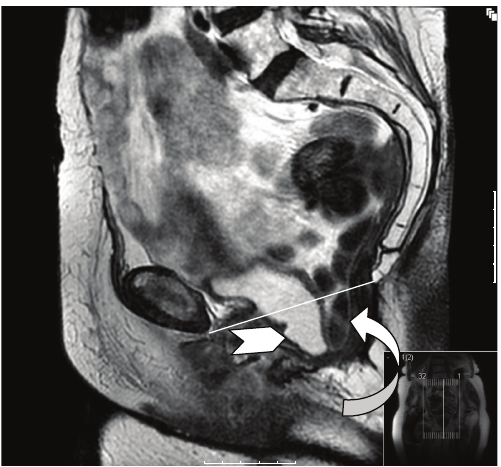
Figure 3: T 2 -weighted saggital view. Patient underwent a conven- tional abdominoperineal excision with primary closure of the pelvic floor. Images are obtained in a supine position with the patient per- forming a Valsalva. There is abnormal descent ( > 1cm) of the pelvic floor with posteroinferior herniation of the bladder (arrowhead) and small bowel (curved arrow) below the pubococcygeal line.